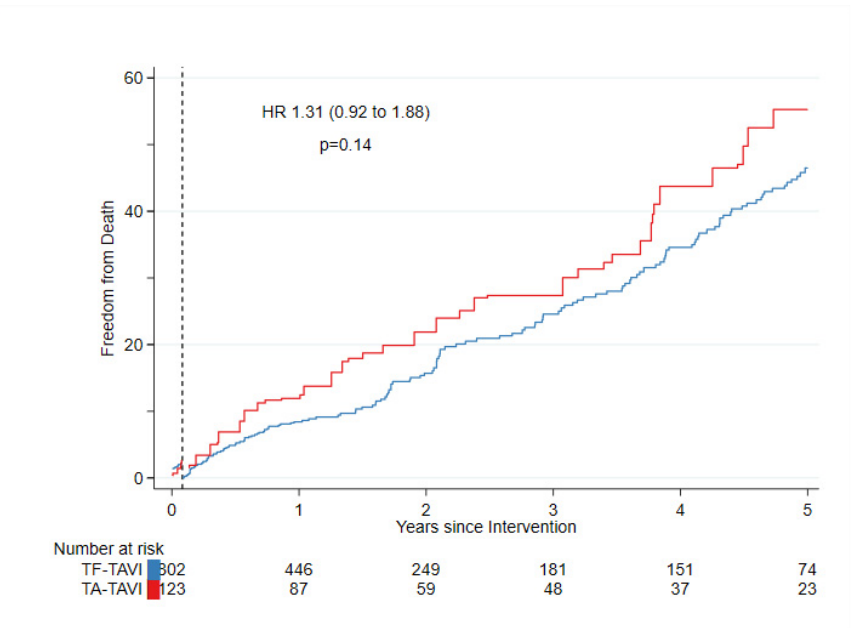
Figure 3. Mortality in patients who underwent TA ‐ TAVI was similar to patients who underwent TF ‐ TAVI after IPTW with a landmark inserted at 30 days after the procedure. Table 4. Short and long ‐ term follow up (landmark 30 days).